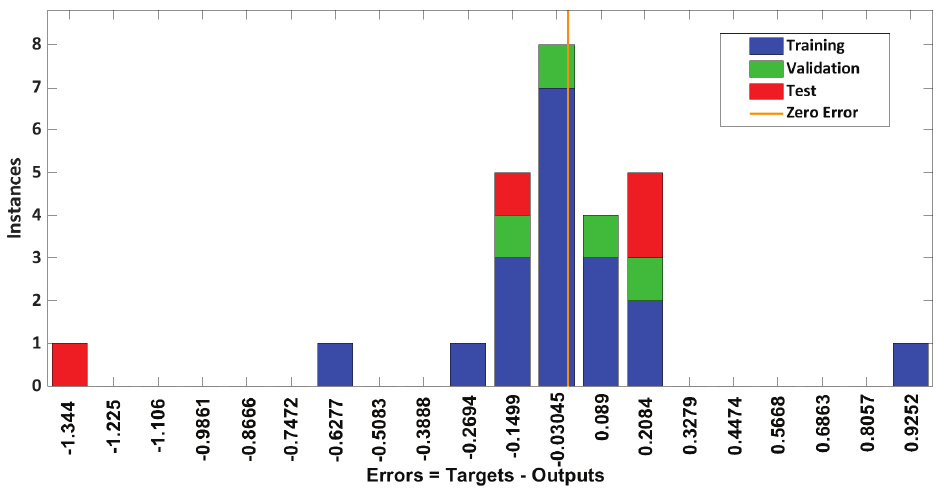
Figure 7. Error histogram with 20 bins for the ANN